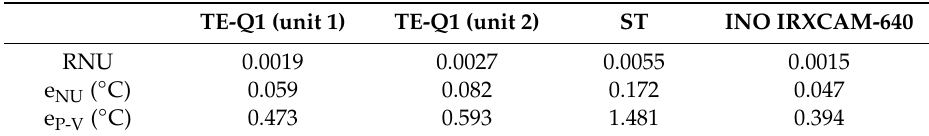
Table 6. Residual non-uniformity (RNU), e NU , and e P-V values at T amb = 25 ◦ C and blackbody temperature T obj = 32 ◦ C.